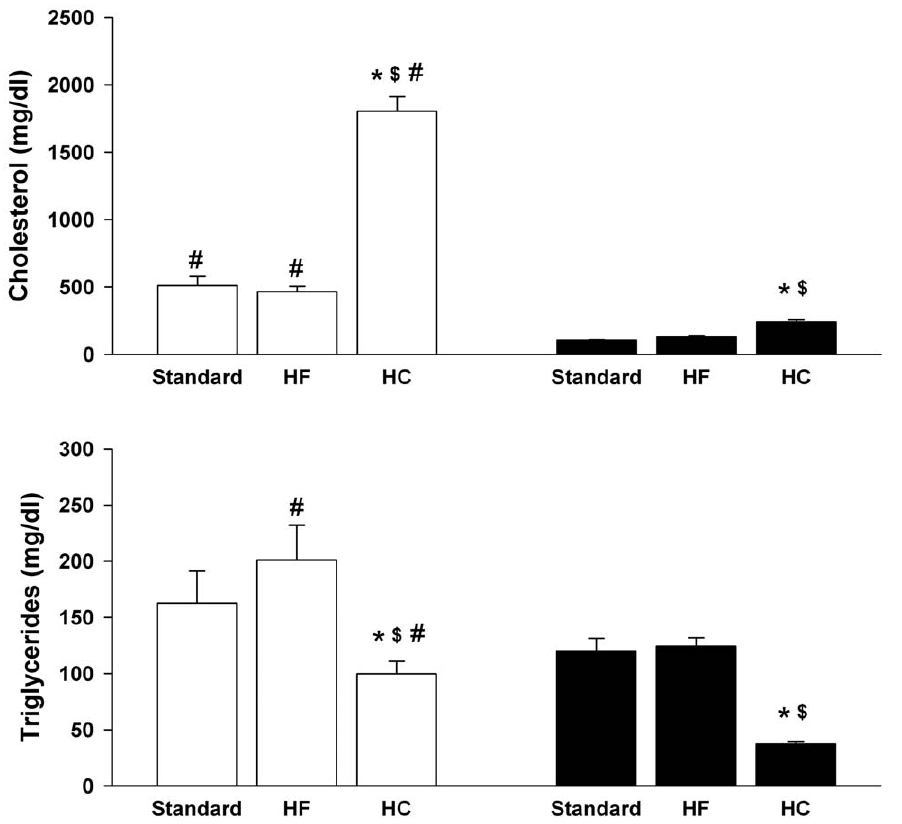
Figure 2. Effect of HF and HC diets on plasma triglycerides and cholesterol. Values are means 6 SE for n=5 mice in each group. Key to symbols: apoE 2 / 2 (open bars); C57BL/6J (black bars); *p , 0.05 vs strain specific standard diet; $ p , 0.05 vs strain-specific HF diet; # p , 0.05 for apoE 2 / 2 vs C57BL/6J fed same diet.